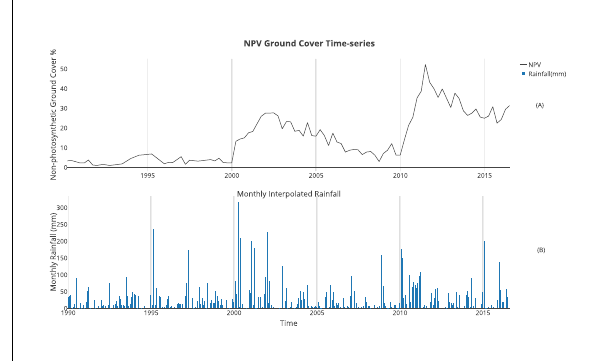
Figure 7. Example of a time-series of non-photosynthetic ground cover (A) in an arid grassland and its corresponding rainfall time-series (B), illustrating the response of ground cover to rainfall.